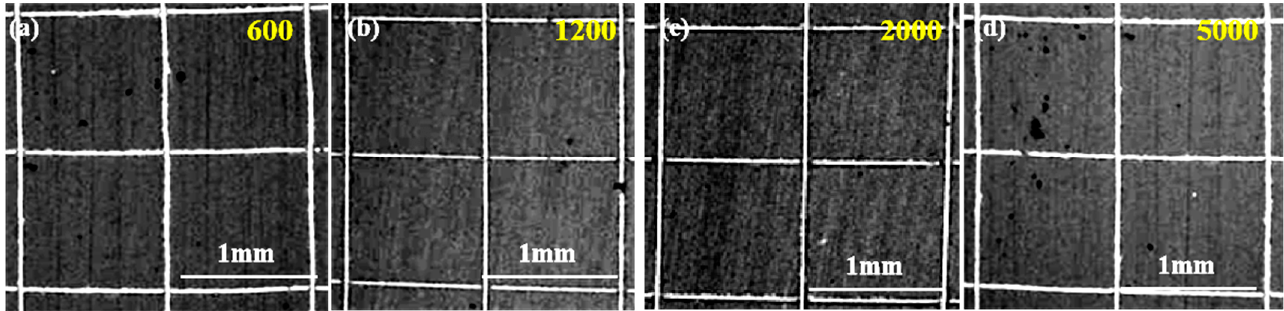
Figure 6. SEM images of ZnAl-LDH films on AZ91D after the tape was peeled off. ( a ), ( b ), ( c ), ( d ).